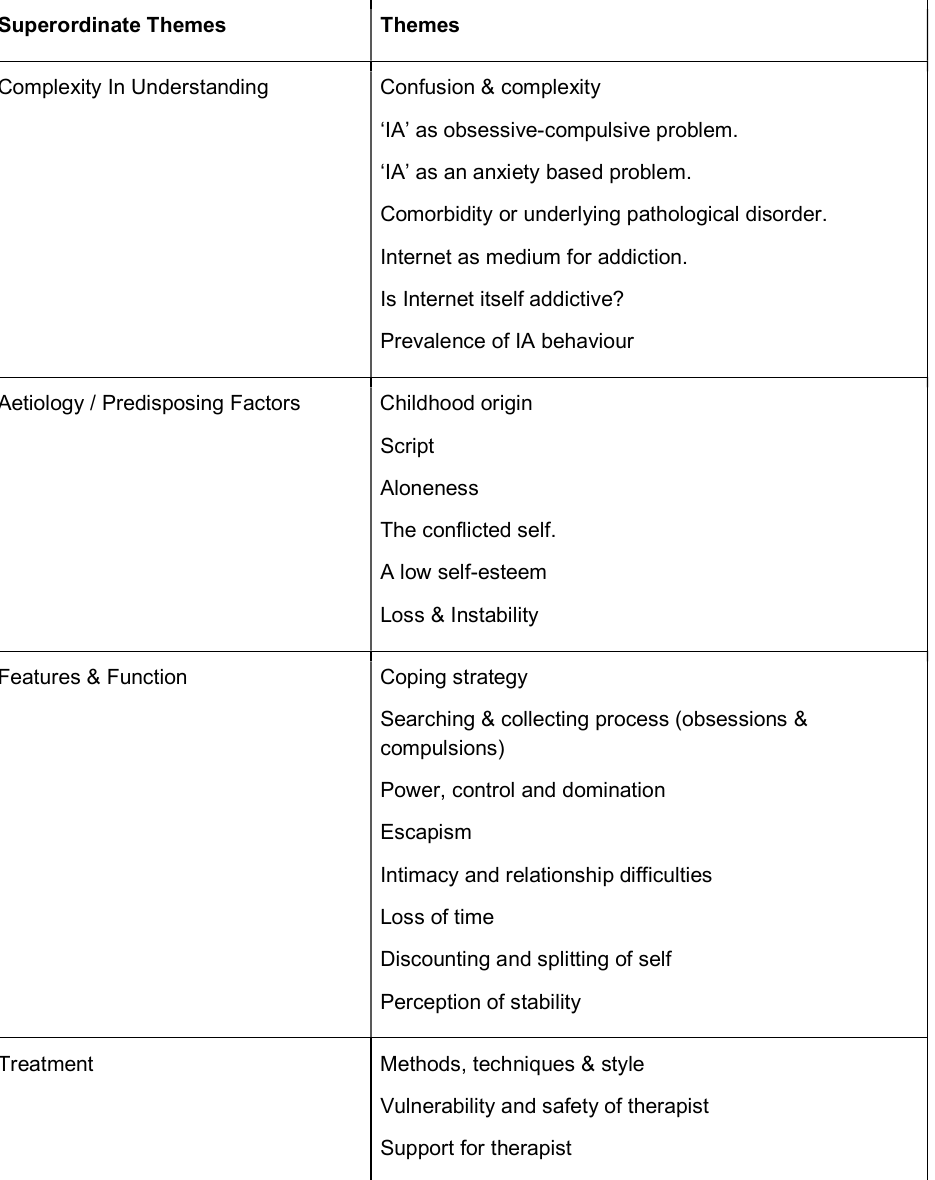
Table 1: Summary of themes whether IA is in fact a ‘true’ addiction, existing in its own right. Two of the participants referred explicitly to IA in these specific terms (Jack and Lucy), and more often than not, talked of ‘anxiety’ and ‘obsessive compulsive’ thoughts and behaviours simultaneously.